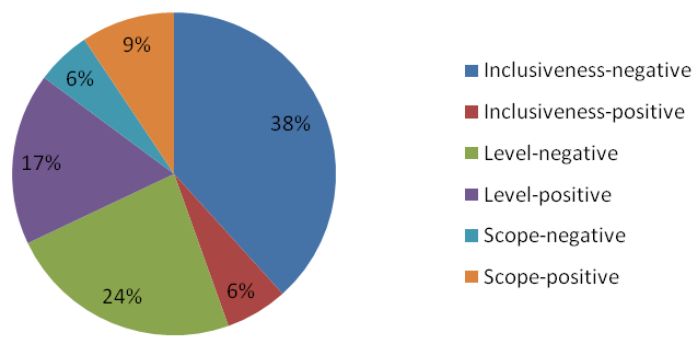
Figure 3. Future of the EU (n = 128).